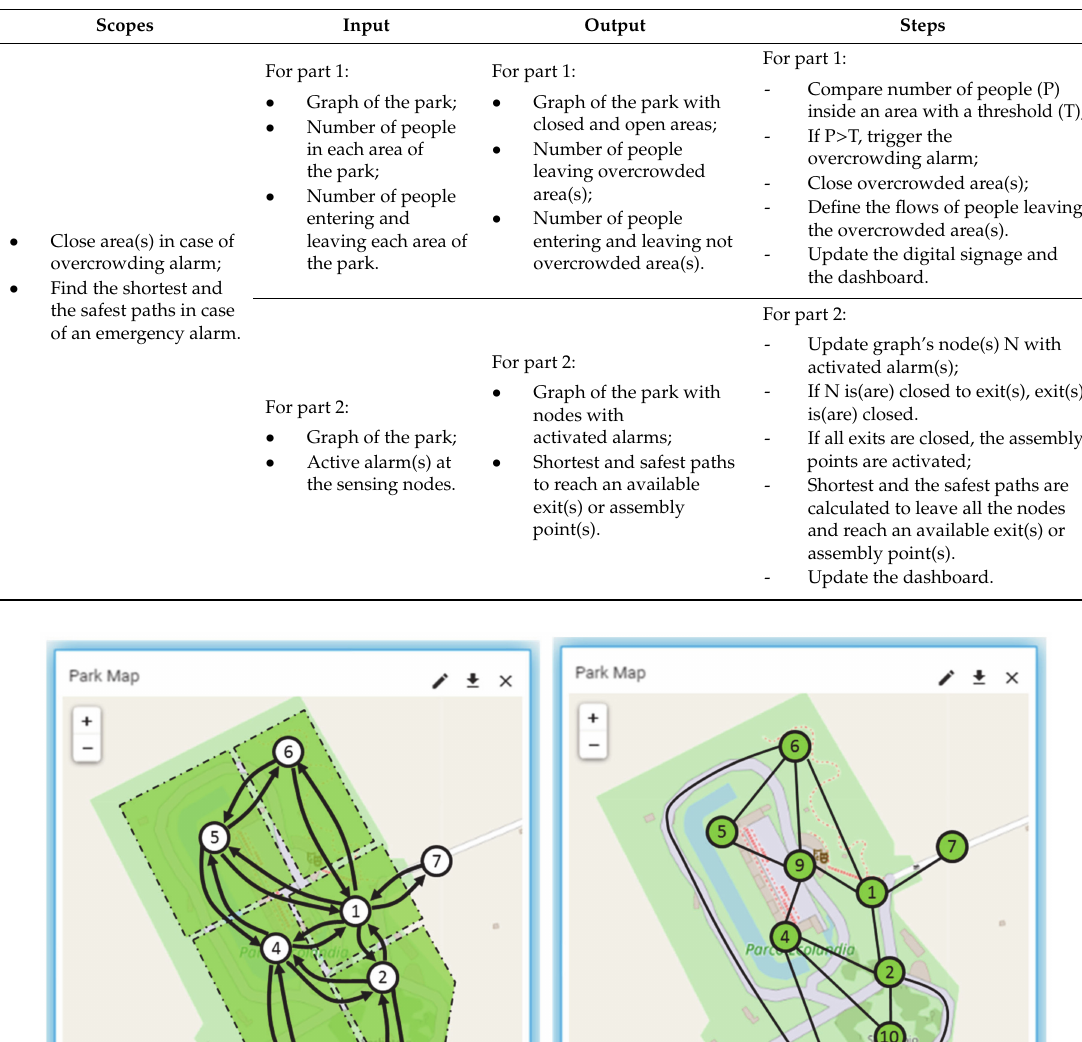
Table 5. Main characteristics of the Algorithm #3 (consisting of two parts).